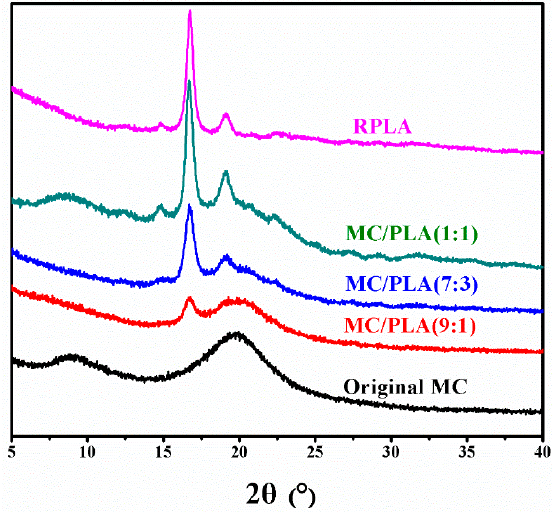
Figure 5. XRD patterns of original MC, MC/PLA membranes, and RPLA.